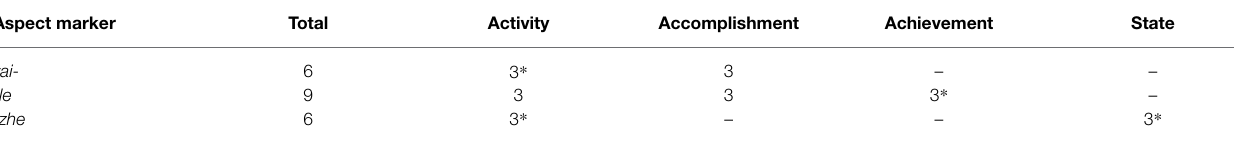
TABLE 2 | Test items in the sentence-picture matching